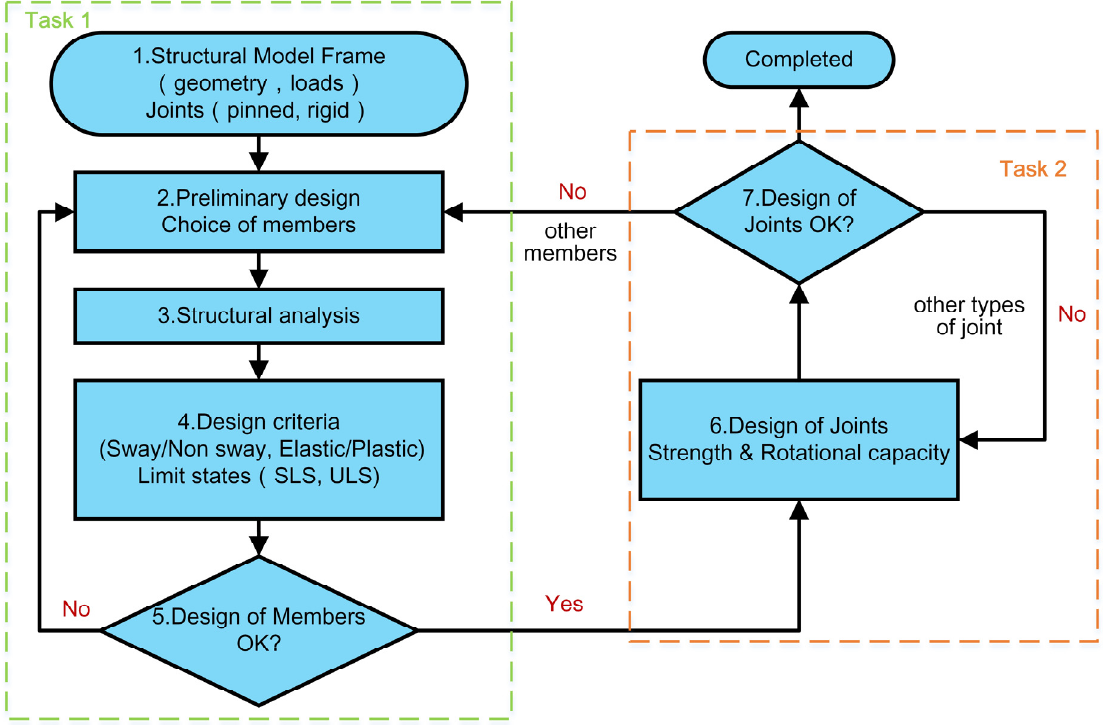
Figure 1. Traditional design flowchart for steel frames.